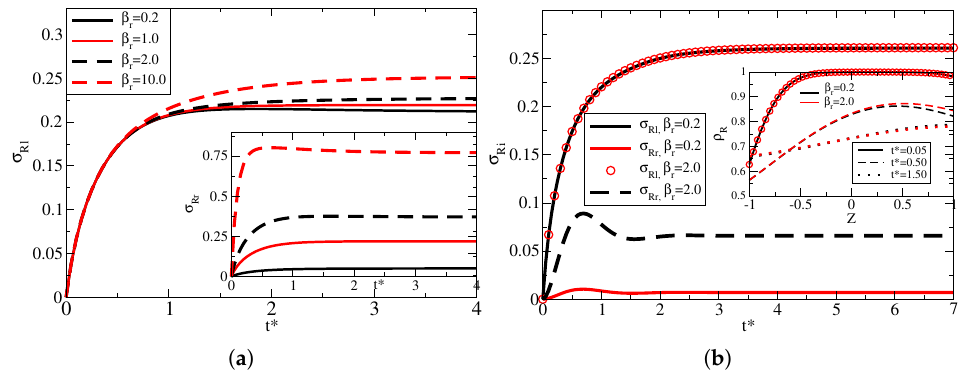
Figure 3. Effect of β on non-identical surfaces. For both figures, the left surface uses β l = 1.0, τ κ l / τ l = 1 and τ al / τ l = 0.01, and the diffusion time is τ al / τ l = 0.01. In ( a ), all the characteristic times of the surface at Z = 1 are the same as the surface at Z = − 1, except the parameter β r . The main figure shows the time evolution of σ Rl , while the inset shows σ Rr . In ( b ), the left surface uses the same parameters as in ( a ), but the right surfaces uses τ κ r / τ r = 10, τ ar / τ r = 20 for β r = 0.2 and β r = 2.0. Both surface dynamics are plotted against t ∗ in the main figure, while the inset shows the bulk distribution for three different values of t ∗ and both values of β r